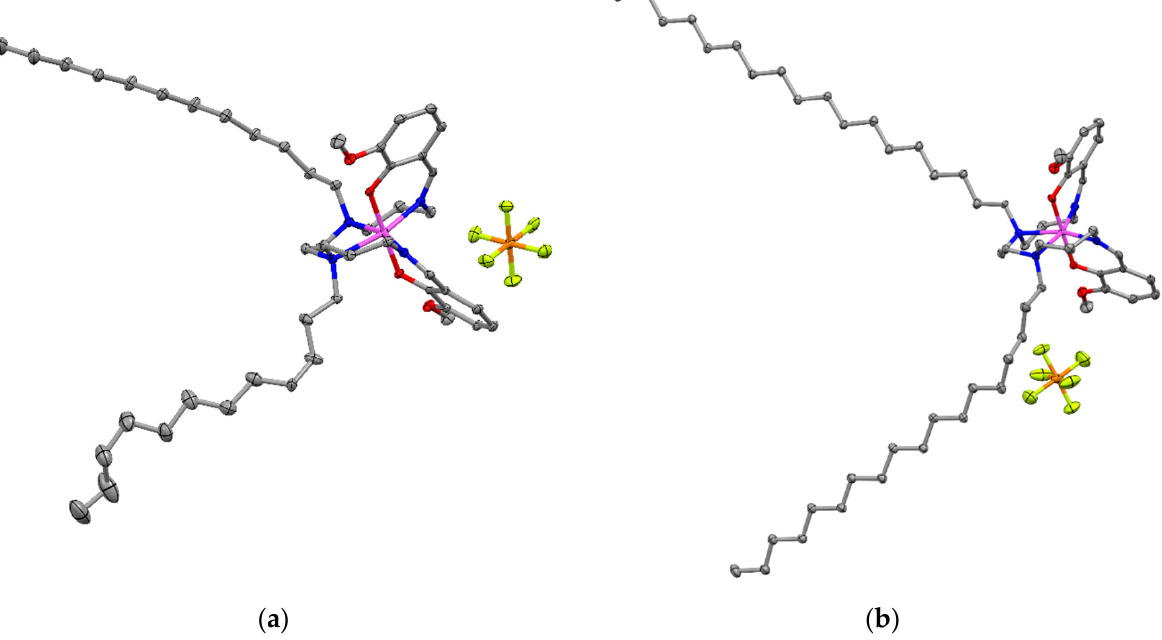
Figure 7. Asymmetric unit of the C 12 containing complex ( 11 ), [Mn(3-OMe-sal 2 323-C 12 )]PF 6 · CH 3 CN ( a ); and the C 18 containing complex ( 12 ), [Mn(3-OMe-sal 2 323-C 18 )]PF 6 · CH 2 Cl 2 ( b ). Data collected at 100 K, interstitial solvent molecules and hydrogen atoms omitted for